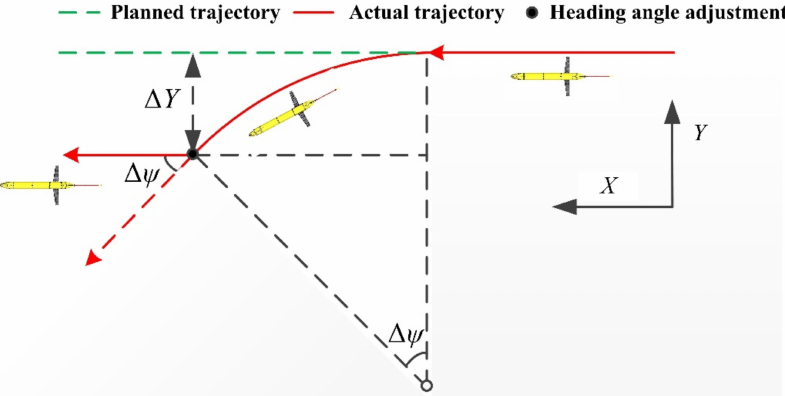
Figure 4. Trajectory error caused by heading adjustment.